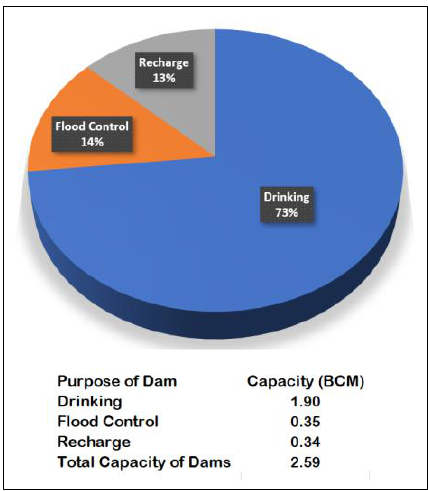
Figure 10. Types of dams in Saudi Arabia and their storage capacities.